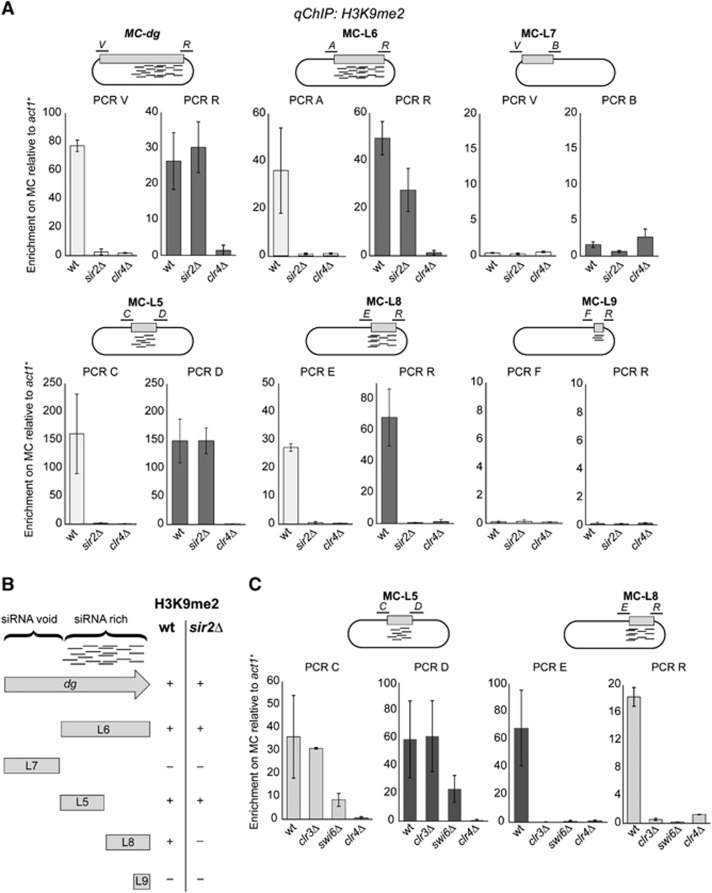
Heterochromatin nucleation over the centromeric dg subfragments in wt, sir2Δ, swi6Δ and clr3Δ cells. (A) qChIP to assess H3K9me2 levels associated with the right and left sides of indicated MC upon transformation into wt, sir2Δ and clr4Δ cells. Enrichment is shown relative to actin (act1+), and normalized to wt. (B) Schematic diagram to summarize MC ability to nucleate heterochromatin in wt and sir2Δ cells. (C) qChIP to assess H3K9me2 levels associated with the right and left sides of MC-L5 and MC-L8 upon transformation into wt, clr3Δ, swi6Δ and clr4Δ cells. Enrichment is shown relative to actin (act1+), and normalized to wt. Error bars: s.d. of three biological replicates in (A) and (C).